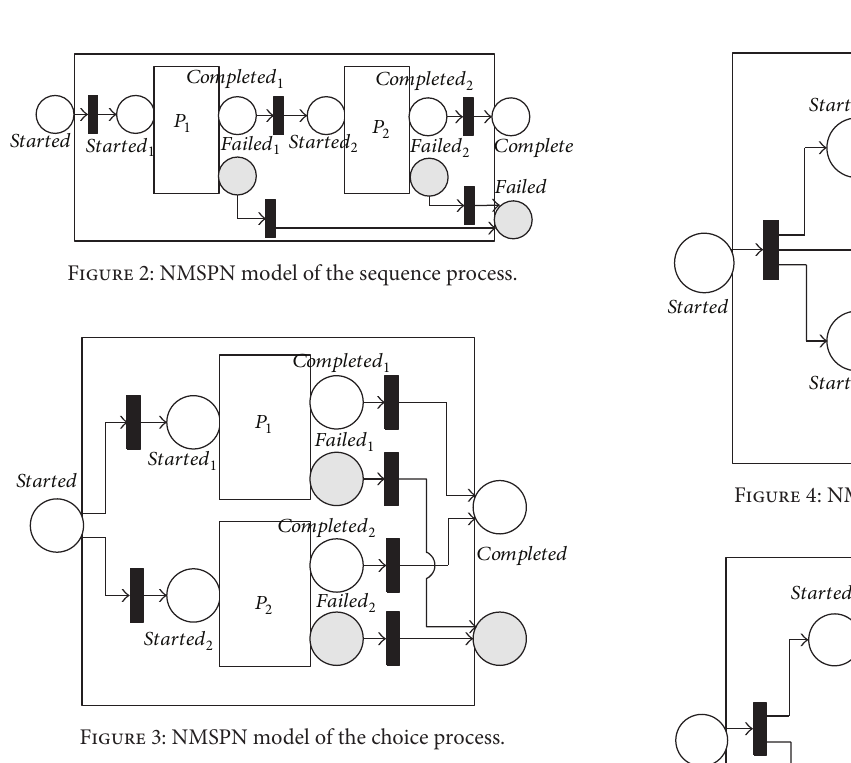
Figure 1: NMSPN model of the atomic process.